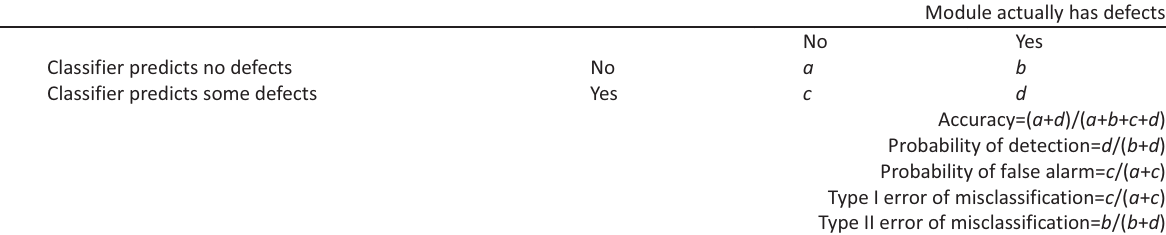
Table 2. Type I and Type II